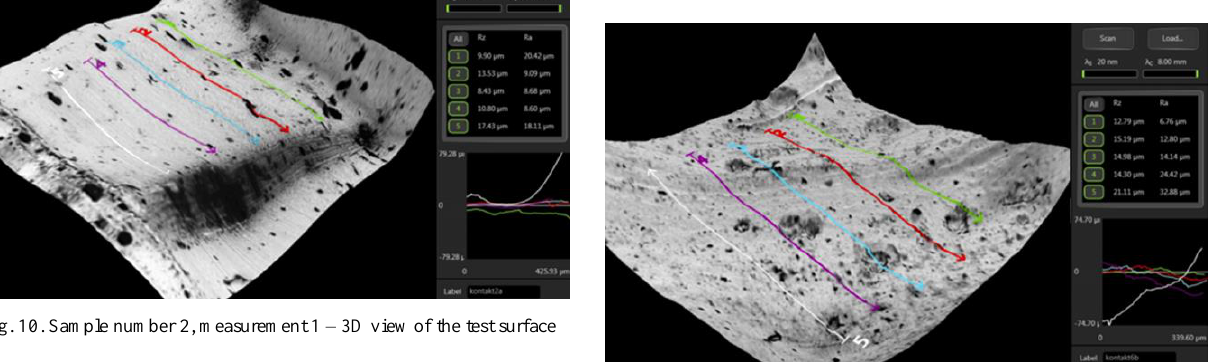
– dark grey patches with irregular shapes visible in Fig.